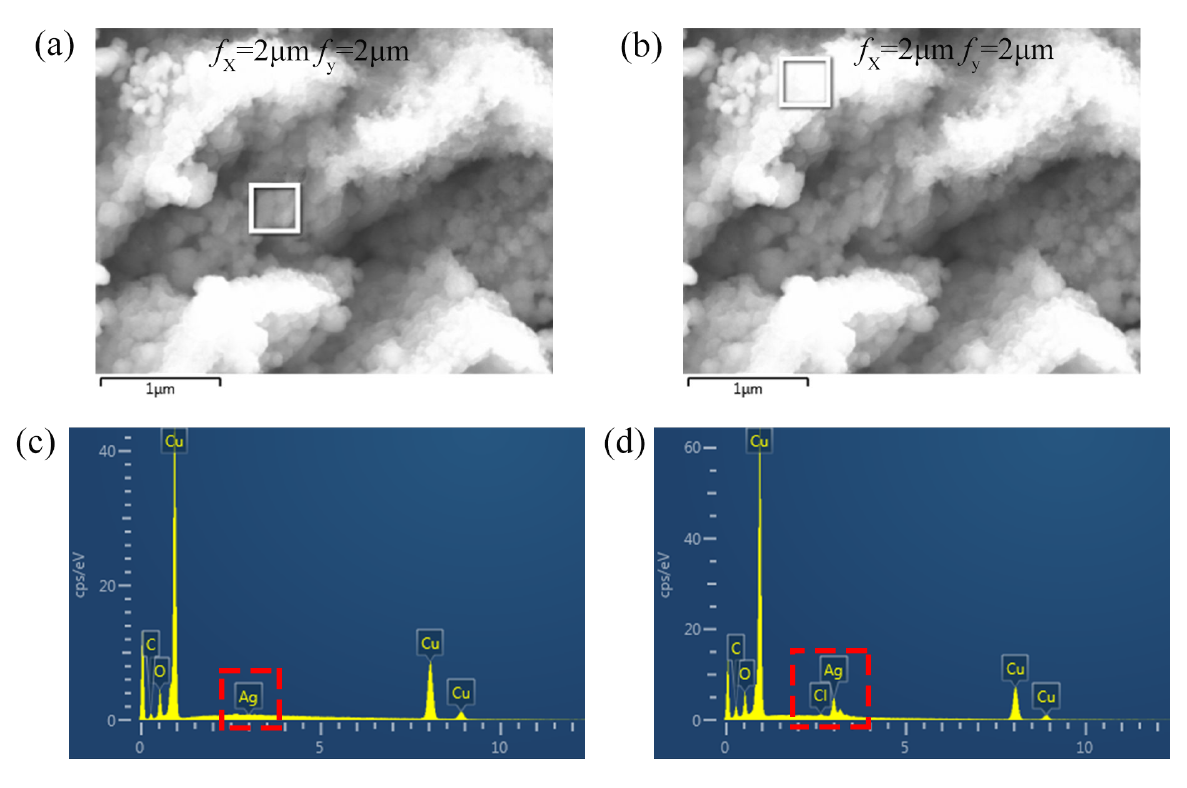
Figure 3: (a) SEM image of the arrayed triangular cavities with f x = 2 μ m, f y = 2 μ m in AgNO 3 solution after 5 minutes. (b) SEM image of the pile-ups of pyramidal cavities with f x = 2 μ m, f y = 2 μ m in AgNO 3 solution after 5 minutes. (c) EDX image of the arrayed triangular cavities with f x = 2 μ m, f y = 2 μ m. (d) EDX image of the pile-ups of the pyramidal cavities with f x = 2 μ m, f y = 2 μ m.